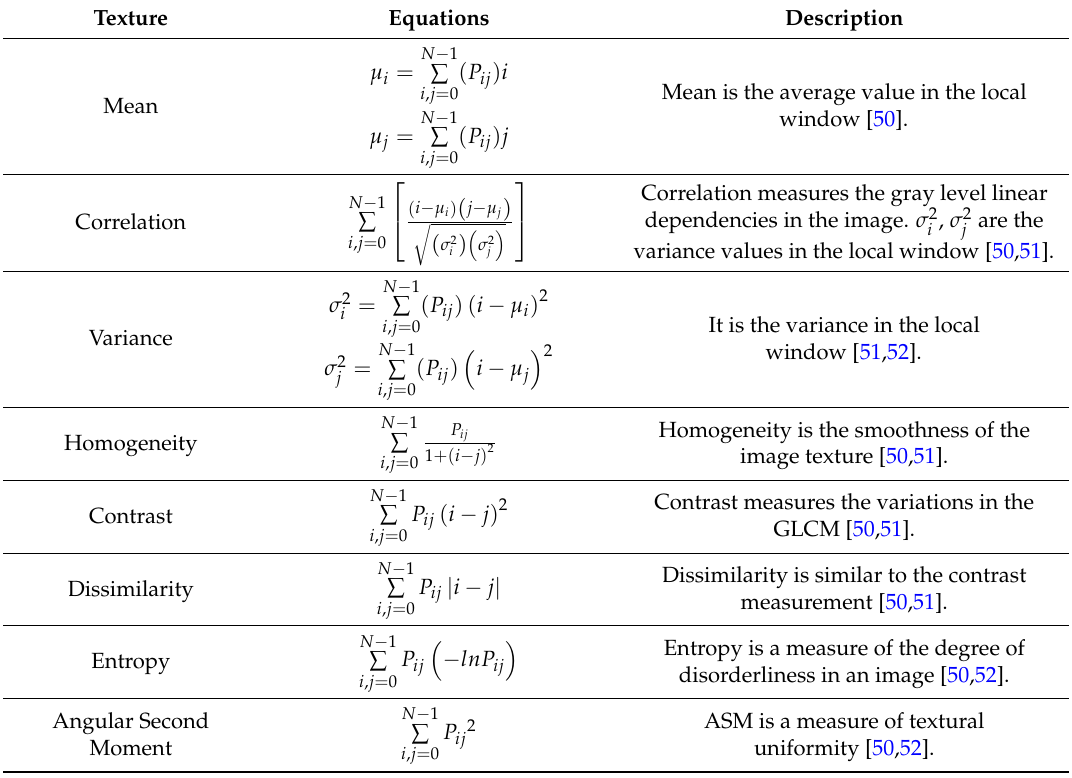
Table 1. The gray-level co-occurrence texture (GLCM) texture